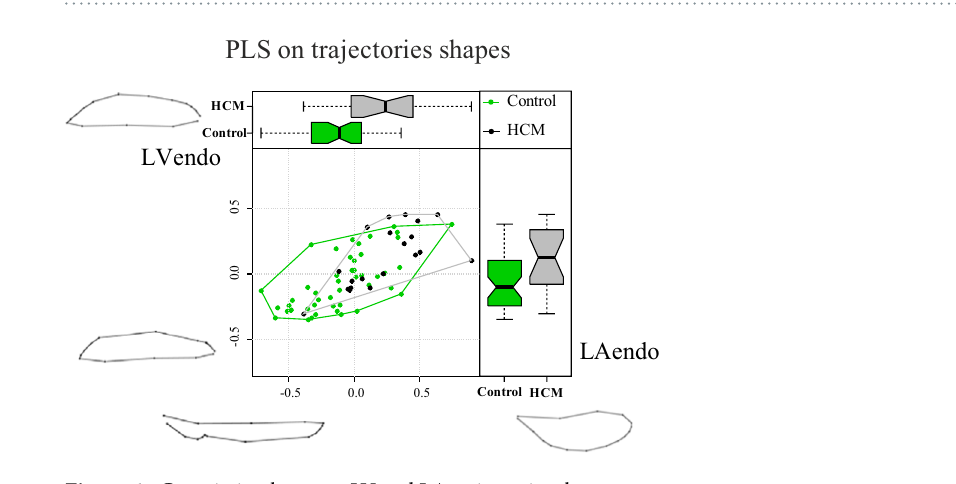
Figure 6. Covariation between LV and LA trajectories